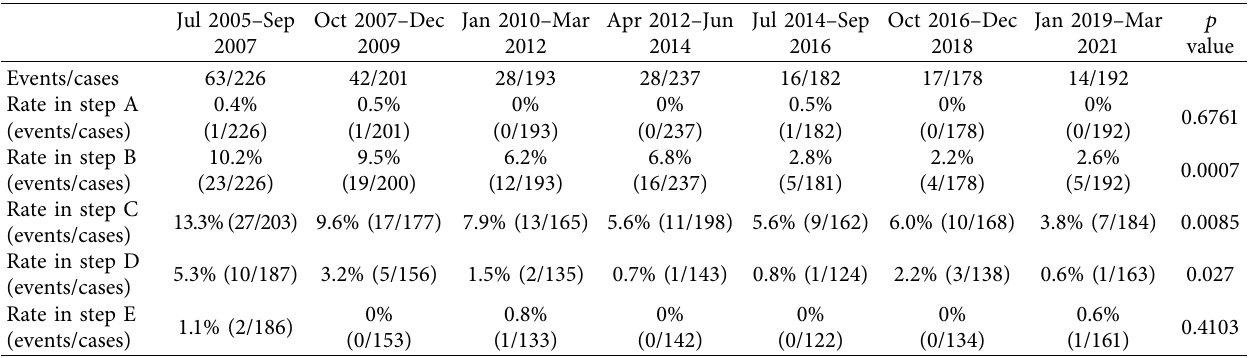
Table 3: Time trend of complication rates in different steps of phacoemulsification performed by residents.